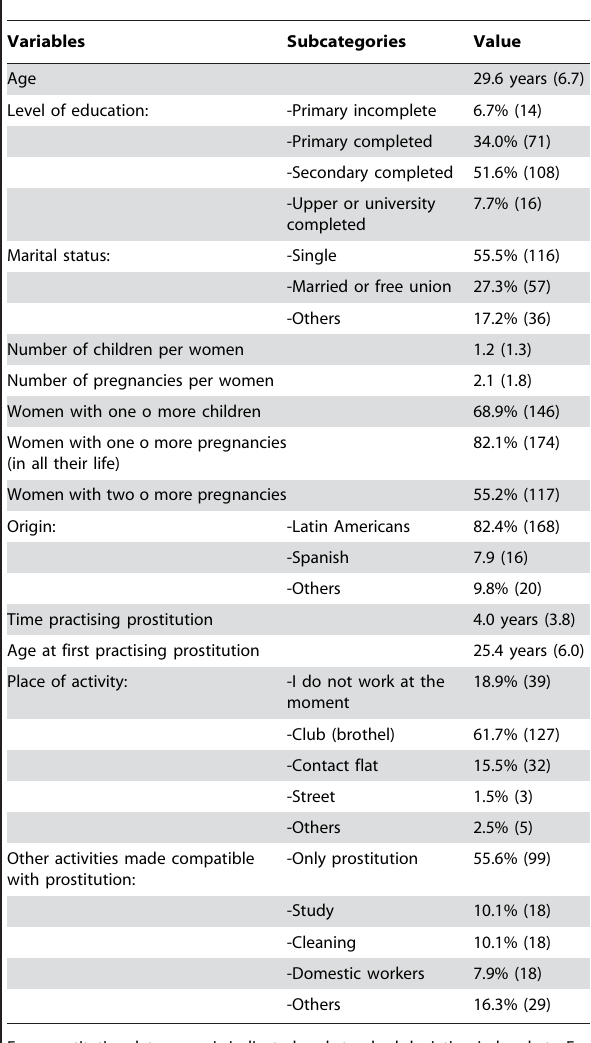
Table 1. Socio-demographic characteristics and variables related to the practise of